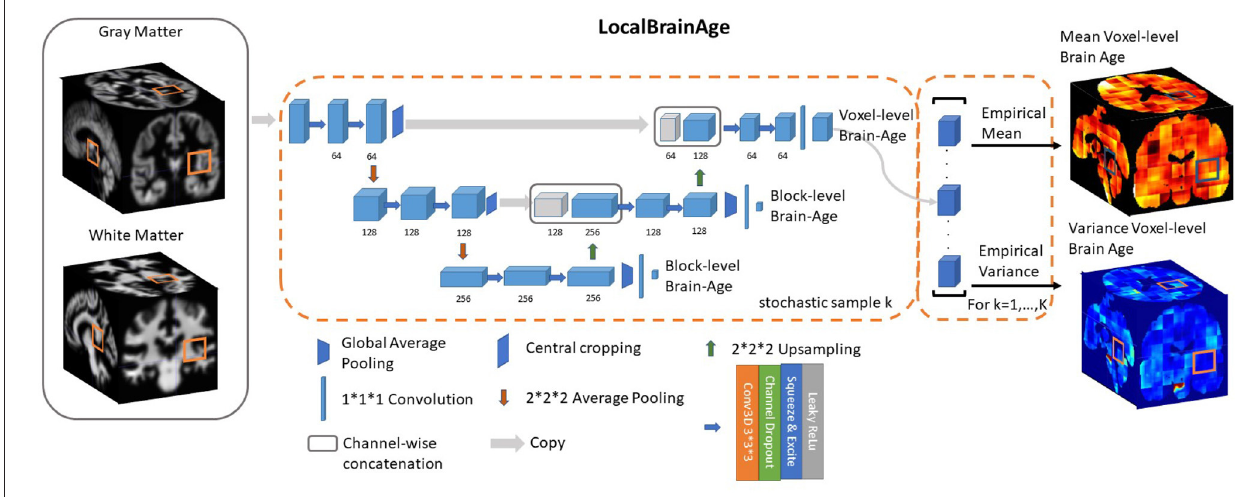
FIGURE 2 | U-Net architecture for voxel-level brain-age prediction. Raw T1-weighted MRI scans were pre-processed using SPM12, obtaining modulated grey and white matter volume maps registered to the MNI152 template. 52 3 blocks of both grey and white matter are passed through U-Net architecture to obtain 12 3 blocks of voxel-level brain-age prediction. Additional auxiliary block-level brain-age loss functions were added at each level of the U-Net to facilitate